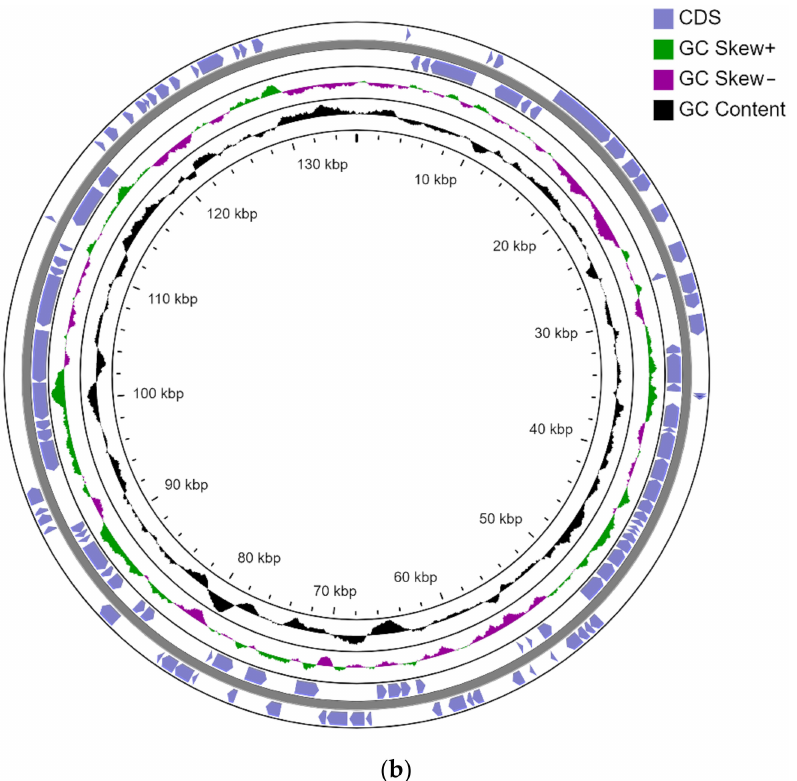
Figure 1. Circle maps of plasmids ( a ) pCP105 and ( b ) pCP135. From outside to the center: all CDS and RNA genes on forward strand, all CDS and RNA genes on reverse strand, GC content, and GC